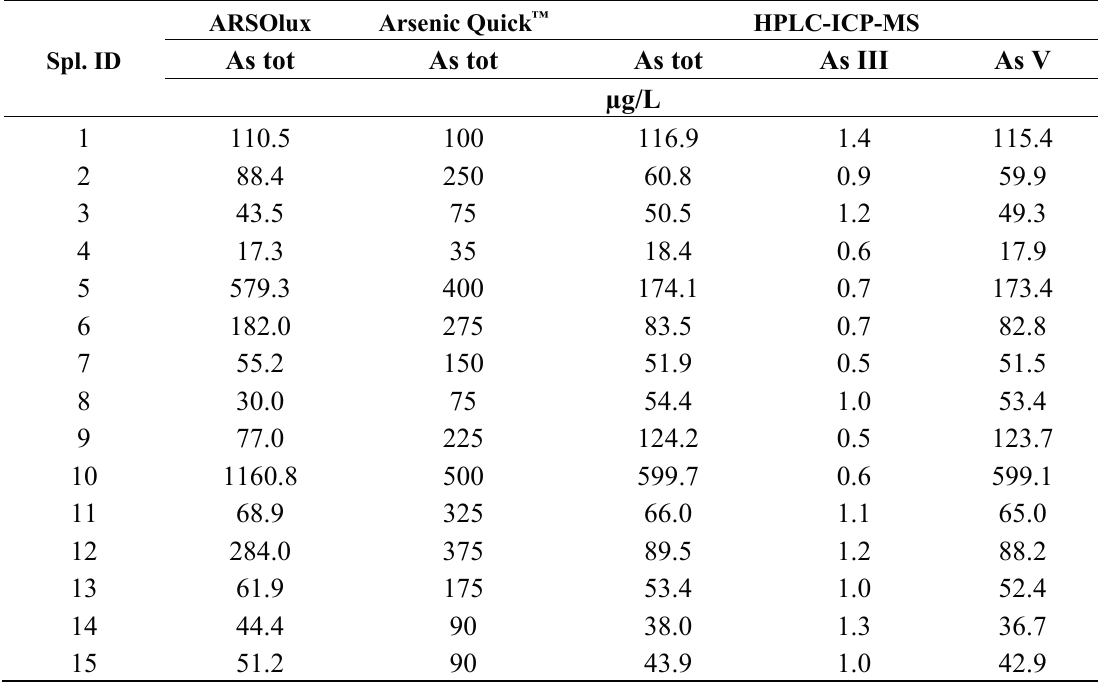
Table A3. Arsenic concentrations of 15 groundwater samples taken near Rafaela, Santa Fe province, Argentina (ARSOlux biosensor measured at UTN lab Rafaela, Arsenic Quick ™ measured on site, HPLC-ICP-MS, ICP-MS measured at UFZ lab, Leipzig, Germany). Spl. ID